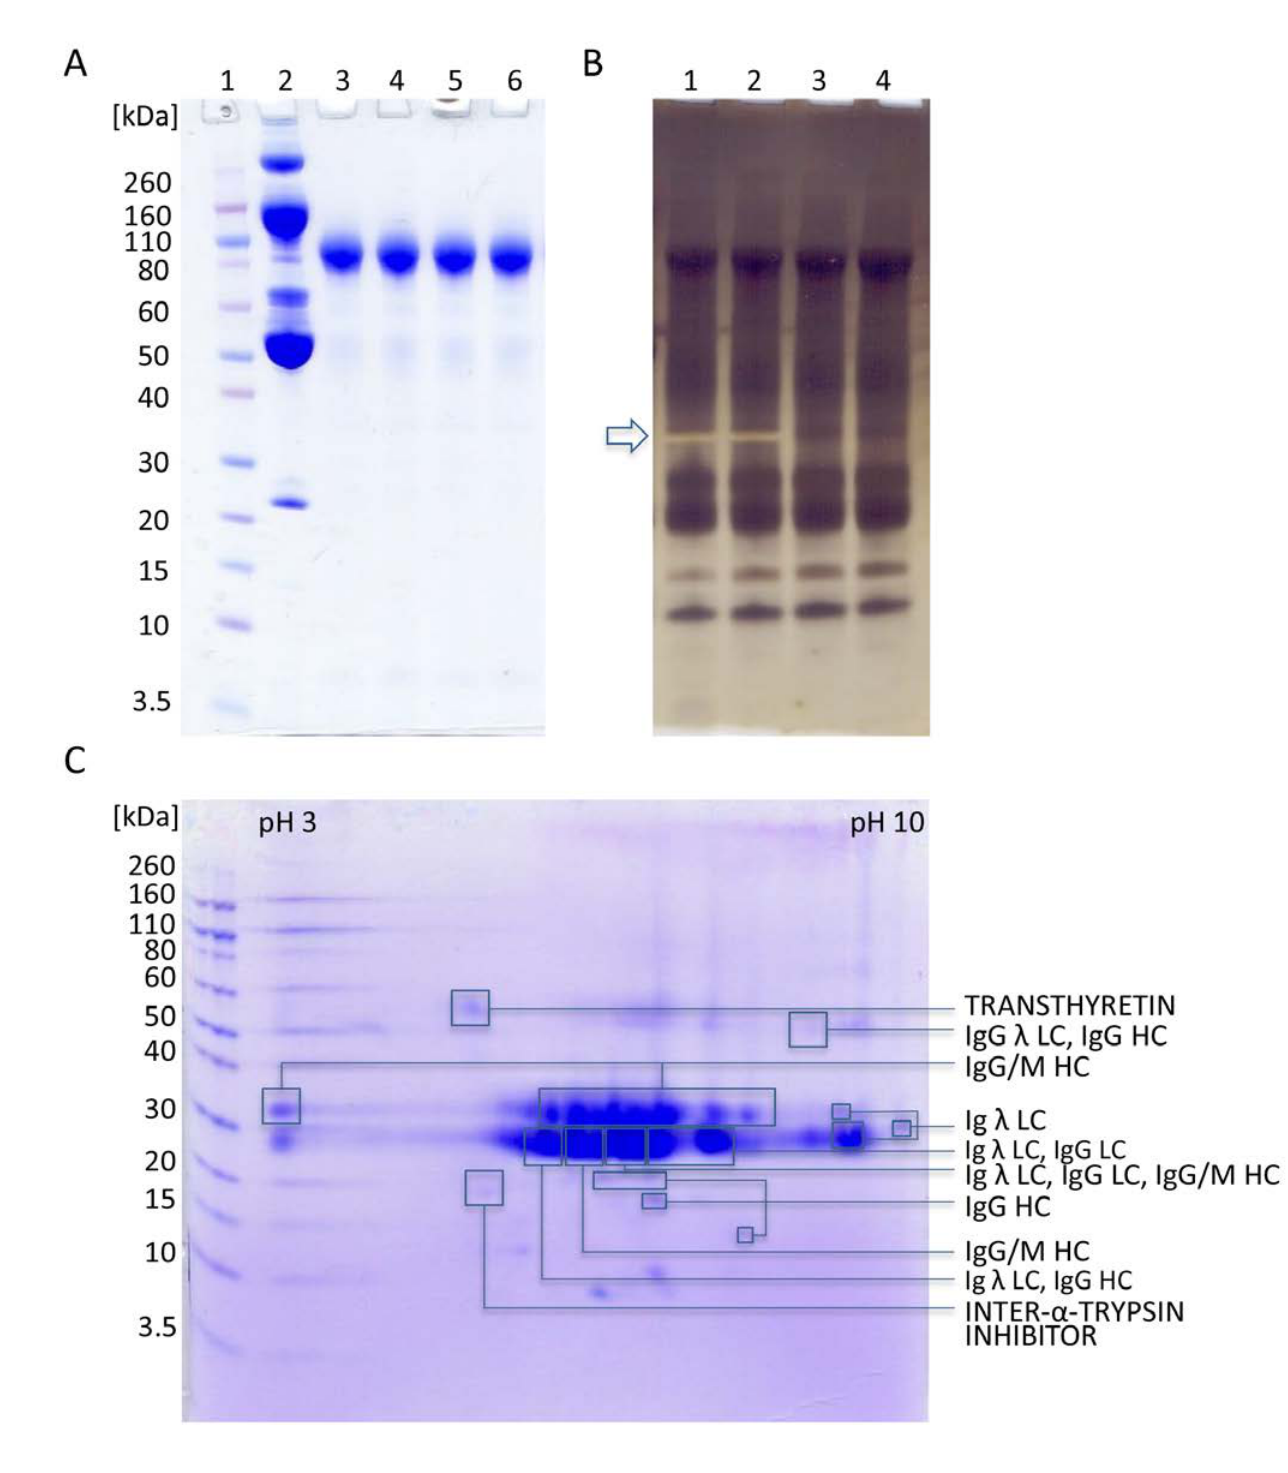
fractions (20 Figure 3. Gel electrophoresis of representative samples from purification process on 4-12% gel. (A) SDS-PAGE analysis of HHP (40 μg) and F(ab’) 2 μg) under non-reducing conditions with CBB R250 staining. Lane 1, molecular weight standards; Lane 2, HHP; Lane 3, F(ab’) fraction obtained by simultaneous 2 2% caprylic acid ( V / V ) precipitation and pepsin digestion (crude F(ab’) ); Lane 4, F(ab’) fraction after diafiltration (pure F(ab’) ); lanes 5 and 6, F(ab’) preparation 2 2 2 2 using CIM QA chromatography (ultrapure F(ab’) product. In the first dimension F(ab’) (350 μg) was focused using IPG strip under denaturing conditions (linear pH 3-10). Prior second dimension IPG strip was 2 reduced, alkylated and loaded to a 4-12% gel. Proteins were detected with CBB R250 and identified by MS/MS analysis (LC = light chain, HC = heavy chain). Molecular mass markers are on the left